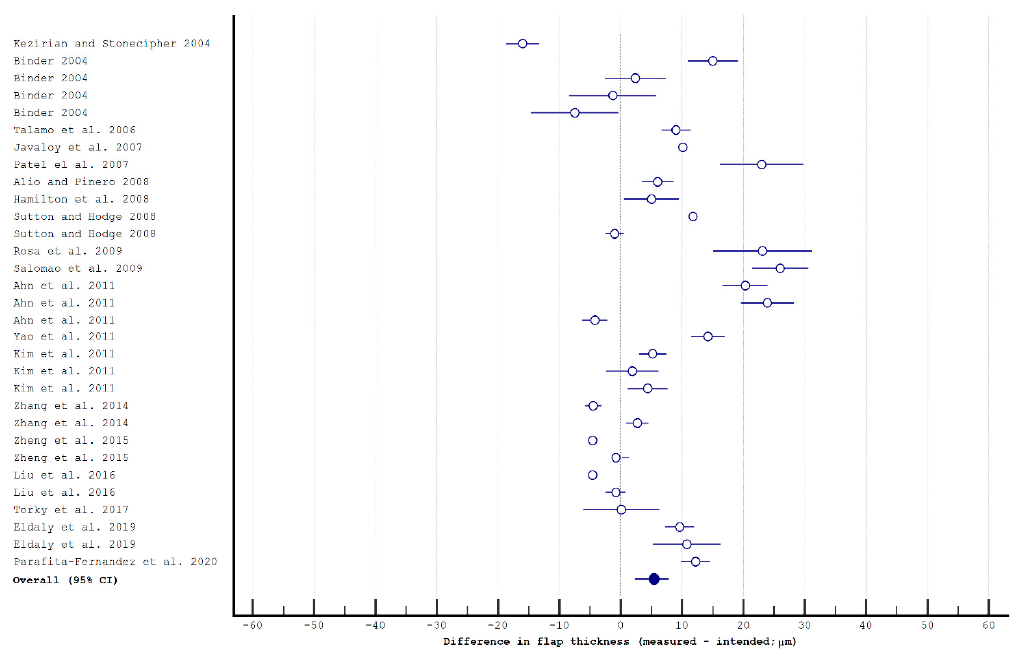
Figure 2. The flap thickness in femtosecond laser in situ keratomileusis. The configuration of flaps created using a femtosecond laser is different from those created with MMKs. For femtosecond-laser flaps, the central flap thickness is similar to the peripheral flap thickness; MMK flaps are meniscus-shaped, with the center of the flap thicker than the periphery [27]. This difference was reported in optical coherence tomog- raphy (OCT) studies that compared flaps created with the FS200 laser (Alcon, Fort Worth, TX, USA) and the M2 MMK (Moria, Doylestown, PA, USA) [28], as well as flaps created with the IntraLase (IntraLase, Irvine, CA, USA) and Zyoptix XP MMK (Bausch + Lomb, Rochester, NY) [29]. On the other hand, Ahn et al. noted that the femtosecond laser flap